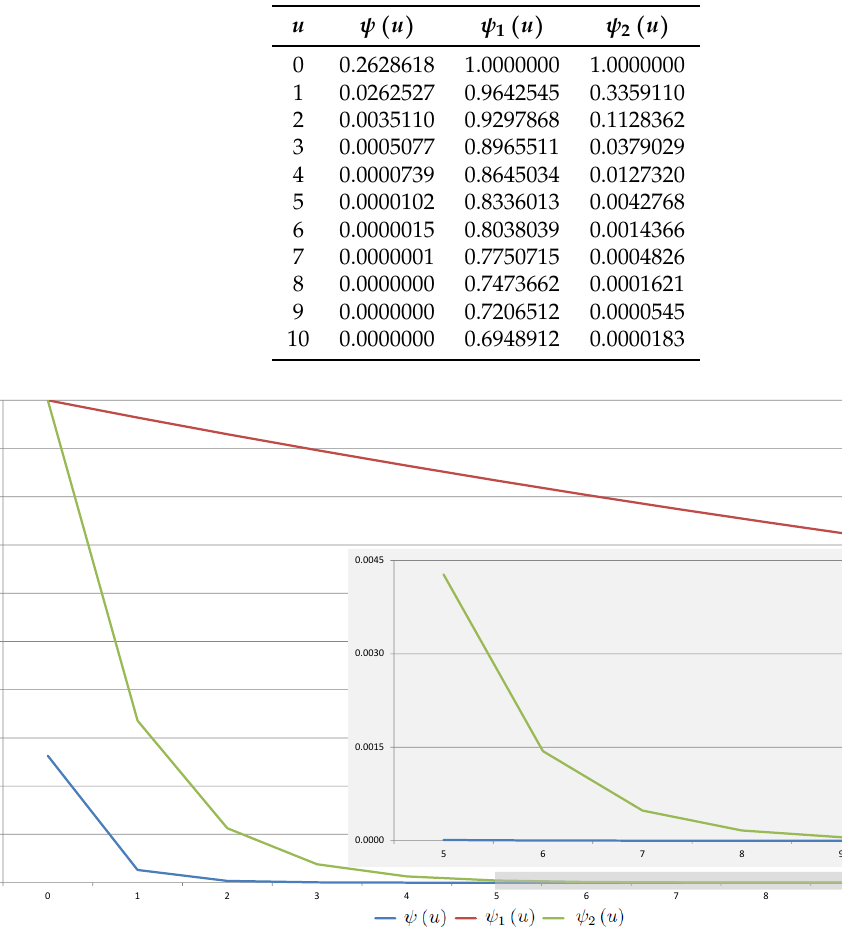
Figure 2. Ruin probability for model of Example